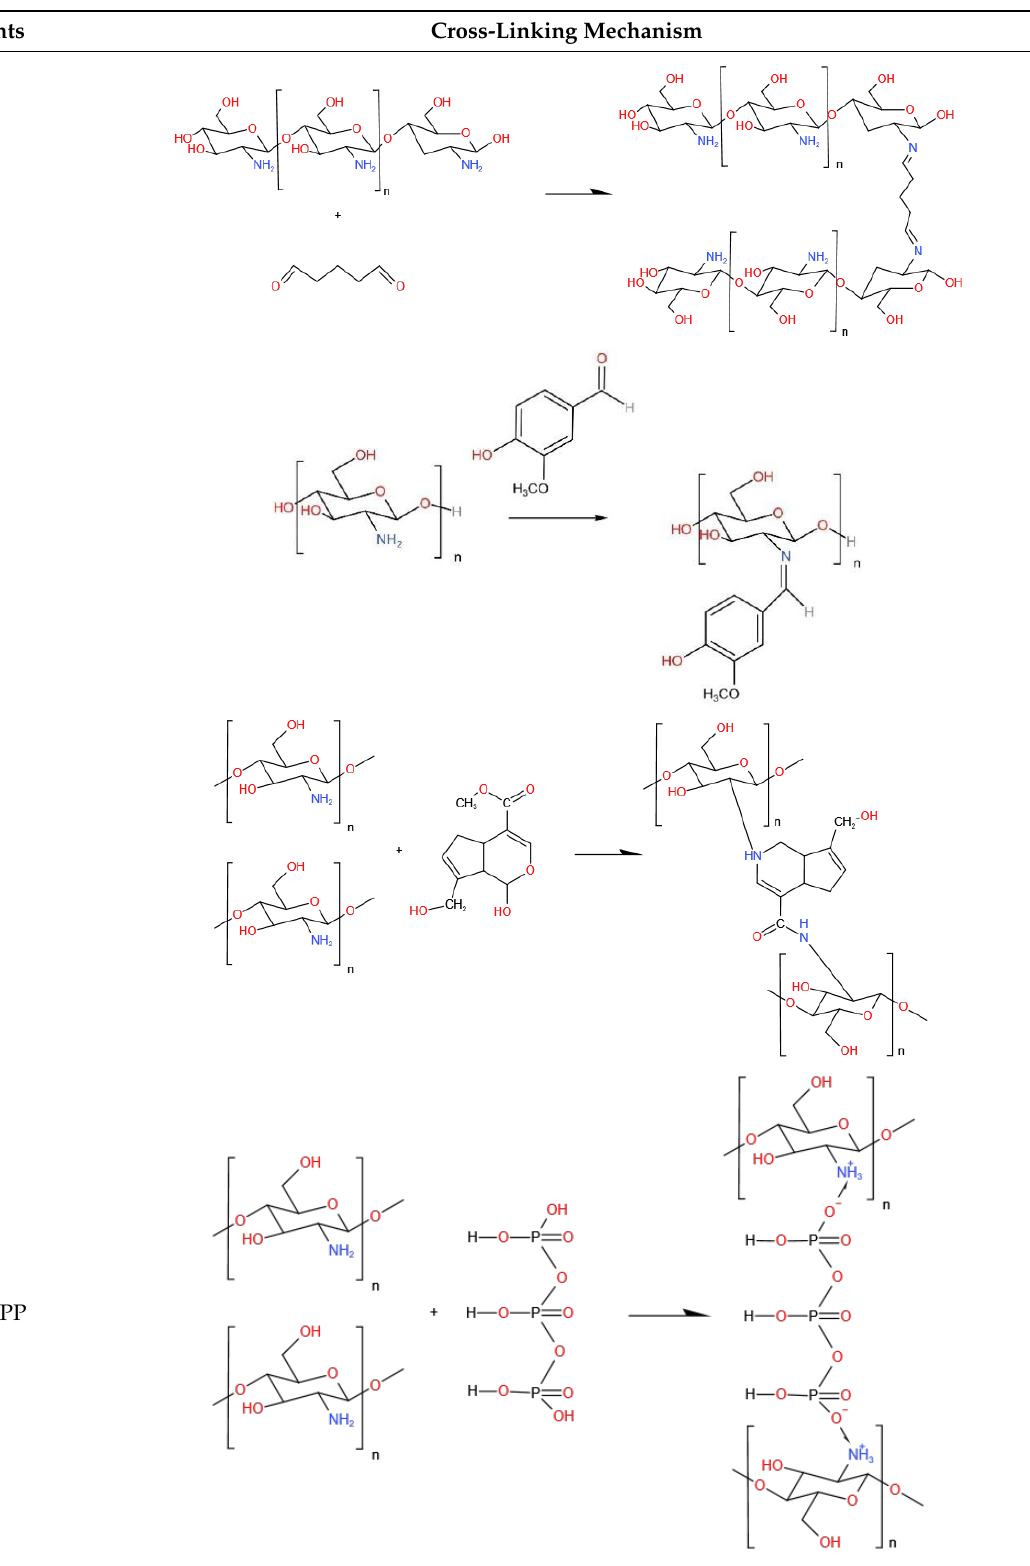
Table 4. Cross-linking mechanism of different cross-linking agents and chitosan.